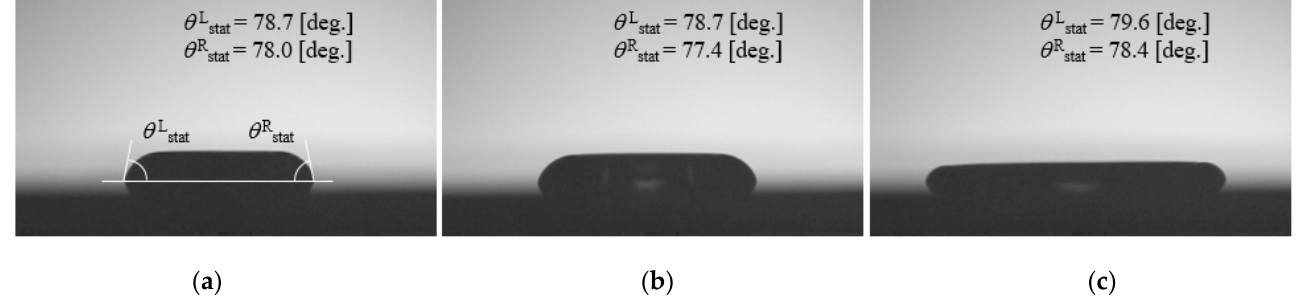
Figure 6. Example of contact angle at the stationary point θ stat for 40 wt% droplets (5.7 μ L) on bare substrate. Snapshots of droplets released from ( a ) 5mm, ( b ) 10 mm, and ( c) 50 mm height. θ stat is evaluated by simple averaging procedure as ( θ L stat + θ R stat )/2.